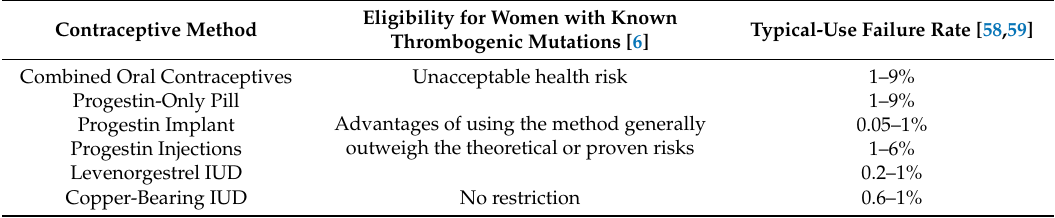
Table 1. Safety of highly effective contraceptive methods for women with thrombophilia. Contraceptive